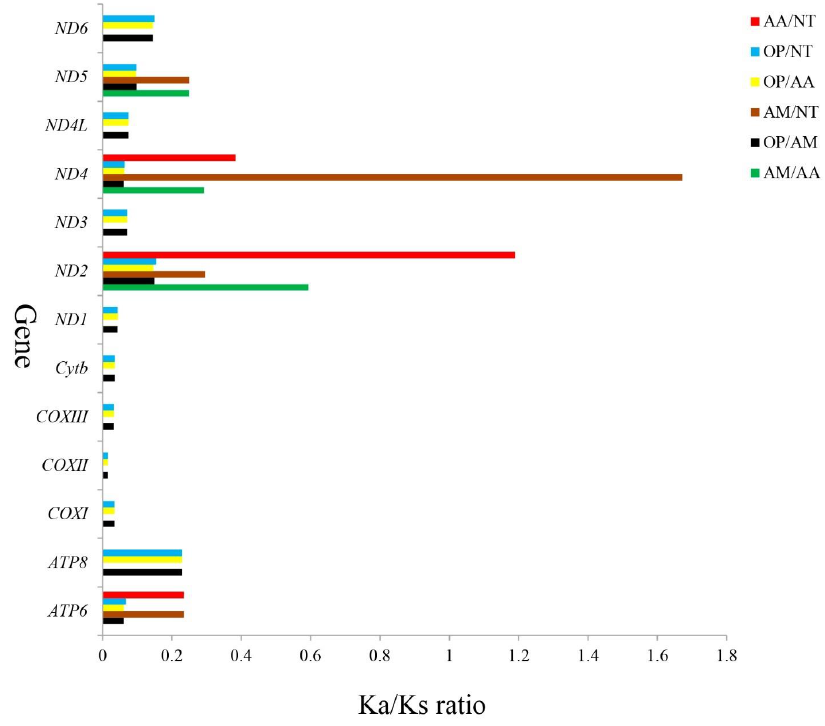
Figure 6. Ka/Ks ratios for the 13 PCGs among the reference A. maculatus (AM), A. arius (AA), N. thalassina (NT), and O. platypogon (OP).